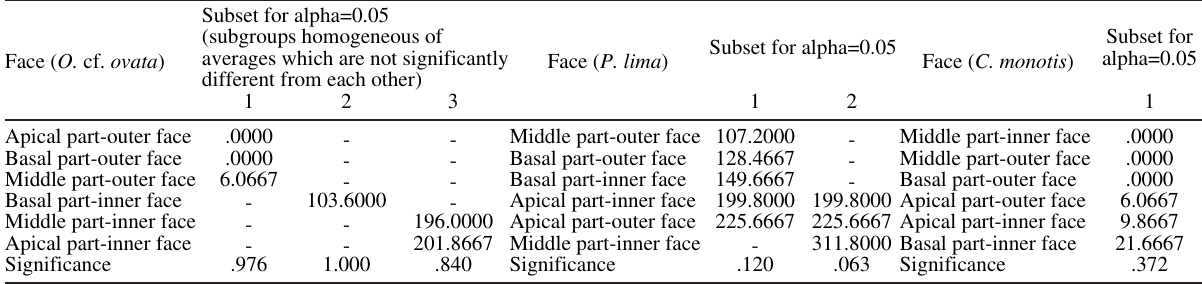
Subset for Subset for alpha=0.05 alpha=0.05 Face ( P. lima ) Face ( C. monotis )